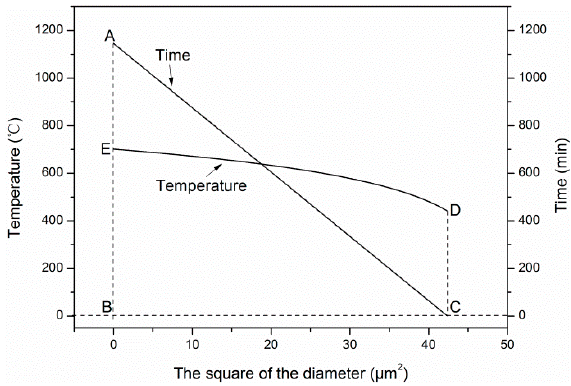
Figure 18. Equivalence of exposure temperature and time on the diameter.